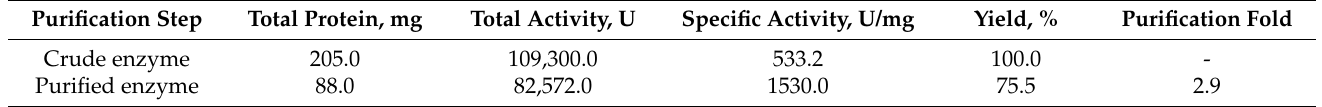
Table 1. Purification yield of recombinant type II L-asparaginase from M. roseus (MrAII).